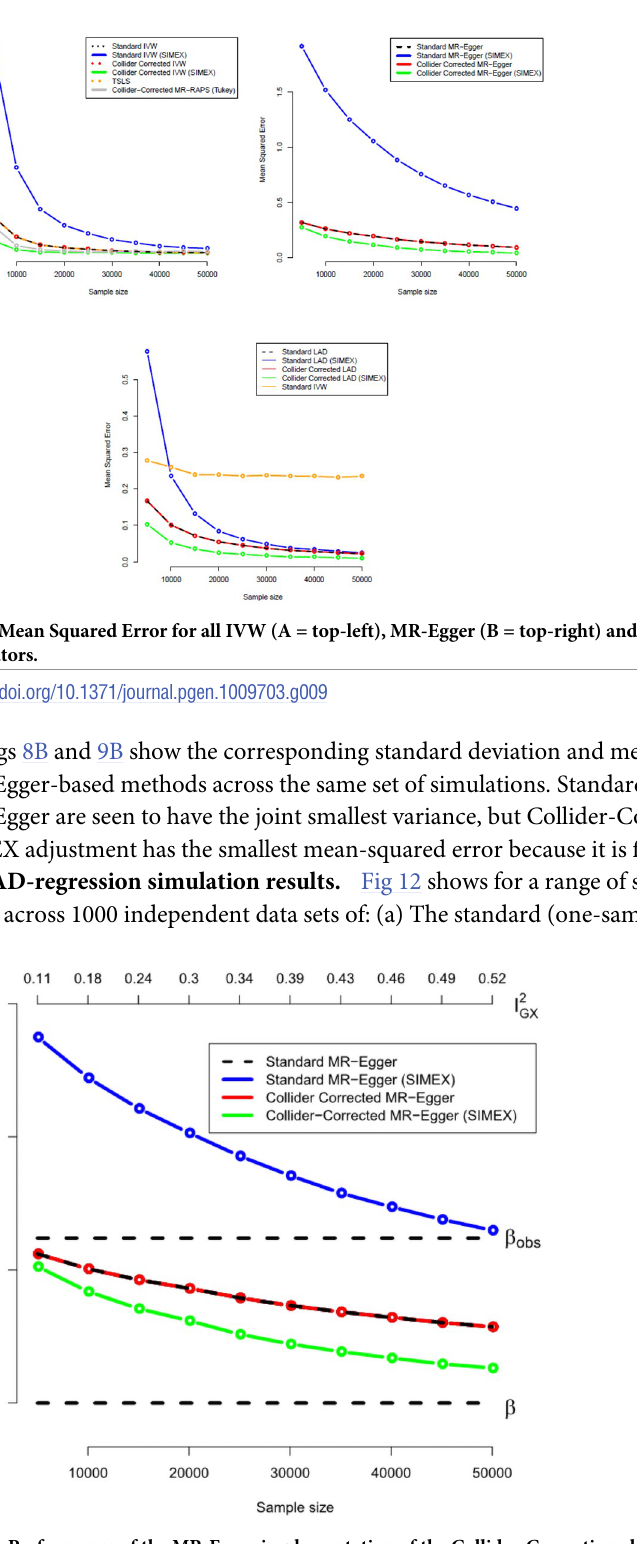
Fig 10. Performance of the MR-Egger implementation of the Collider-Correction algorithm under a directional pleiotropy